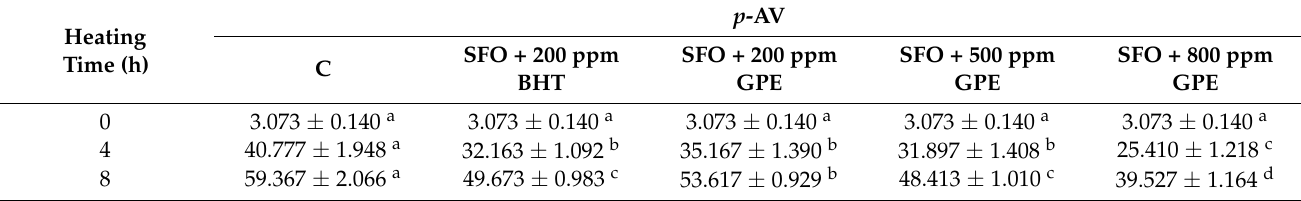
Table 4. Changes in para -anisidine values ( p -AV) of sunflower oil (SFO) samples with the addition of GPE and BHT during convective heat exposure compared to the control sample